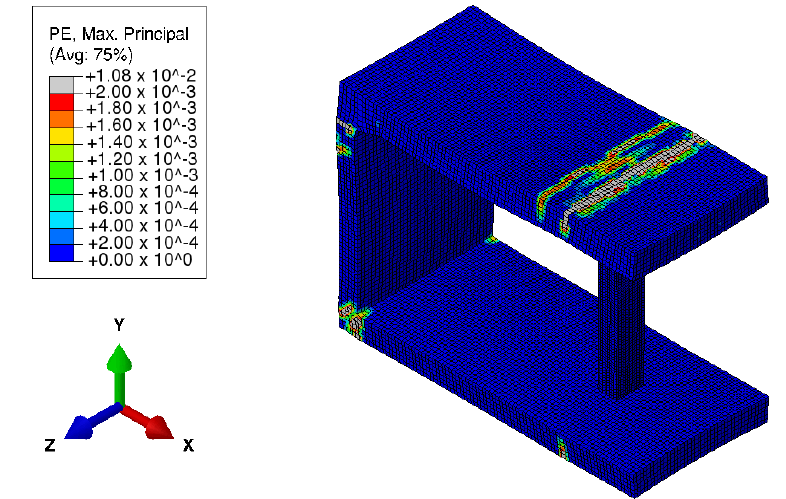
Figure 26. Plastic strains, developed on the outer surface of the top slab at its connection to the column right after the onset of cracking, as obtained from a thermomechanical simulation based on temperature-dependent and elasto-plastic material behavior, as well as on the prescription of one uniform surface temperature history; the results refer to the time instant 25 min and 1.2 s after the beginning of the fire